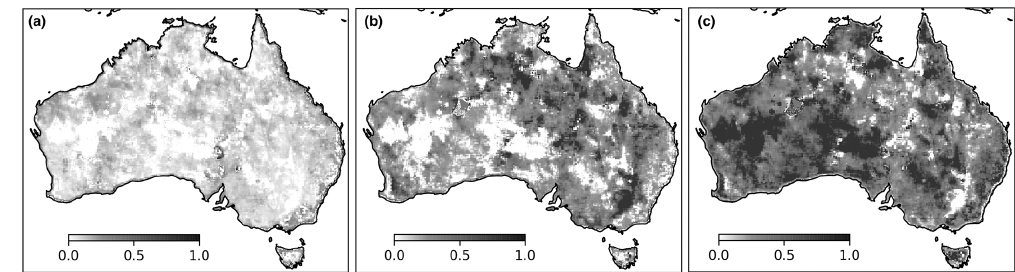
Figure 2. Gain weights for sequential data assimilation derived from triple collocation (TC), showing the relative contribution of the respec- tive estimate in (a) AWRA-simulated surface soil water storage S 0 , (b) SMOS soil moisture and (c) SMAP soil moisture.